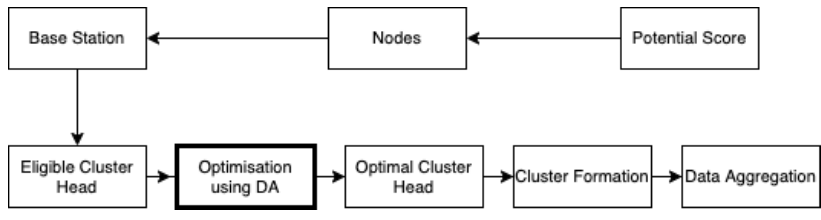
Figure 8. Cluster head selection in RFID network using DA [52].